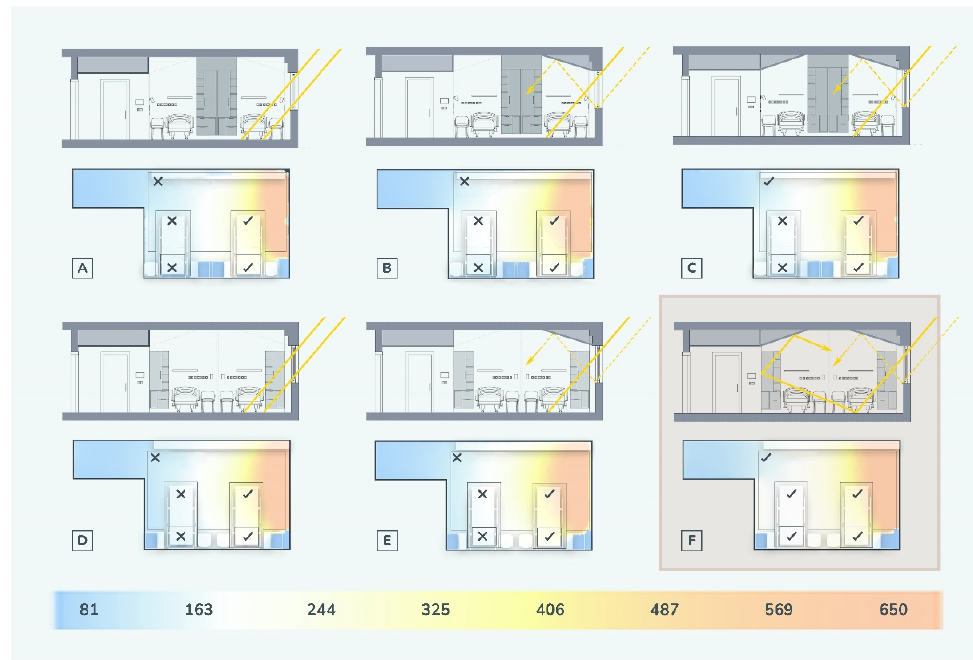
Figure 15. Comparative study of ceiling conformation and furniture arrangement according to natural light distribution. Option ( A ): furniture centrally located between the two beds; no suspended ceiling. Requirements are not met. Option ( B ): furniture placed centrally between the two beds; suspended ceiling on only one side of the room. Requirements are not all met. Option ( C ): furniture placed centrally between the two beds; suspended ceiling on a both sides of the room. Requirements are not all met. Option ( D ): furniture placed between each bed and adjacent wall; no suspended ceiling. Requirements are not all met. Option ( E ): furniture placed between each bed and adjacent wall; false ceiling on only one side of the room. Requirements are not all met. Option ( F ): furniture placed between each bed and adjacent wall; suspended ceiling on a both sides of the room. All re- quirements are met.